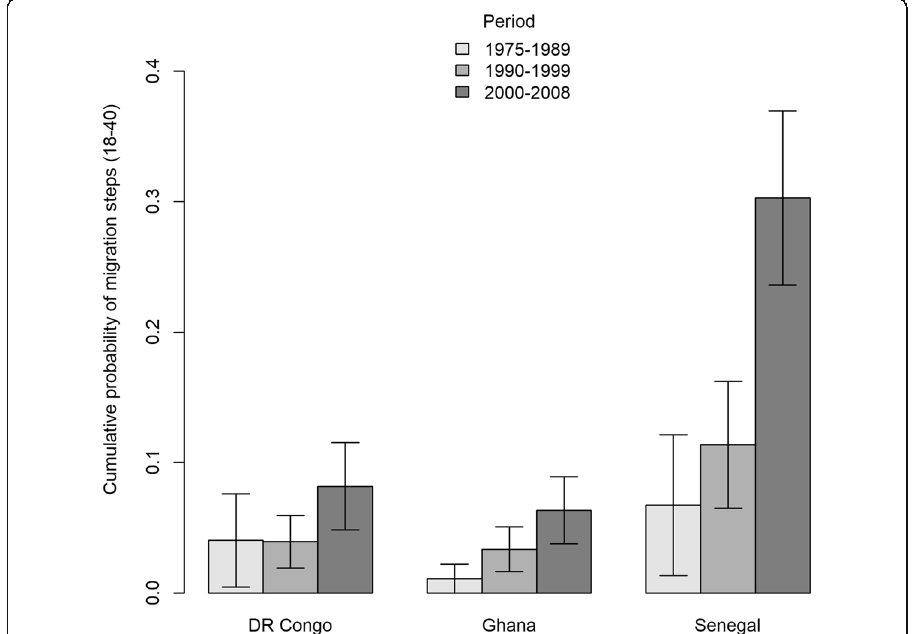
Fig. 8 Lifetime probability of taking steps towards migration to Europe by origin country (1975 – 2008).